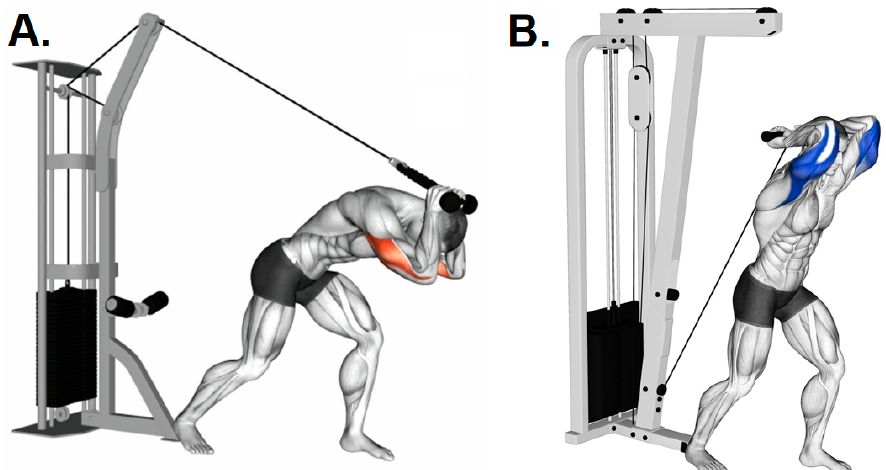
Figure 4. Standing cable overhead triceps extensions: ( A ) this posture generates tension in the myofascial and muscular chains in different ways; ( B ) recommended posture. Source: Taken from Gym Visual available at https://gymvisual.com/ under copyright and owned by Aliaksandr Makatserchyk. Accessed on 14 January 2022.